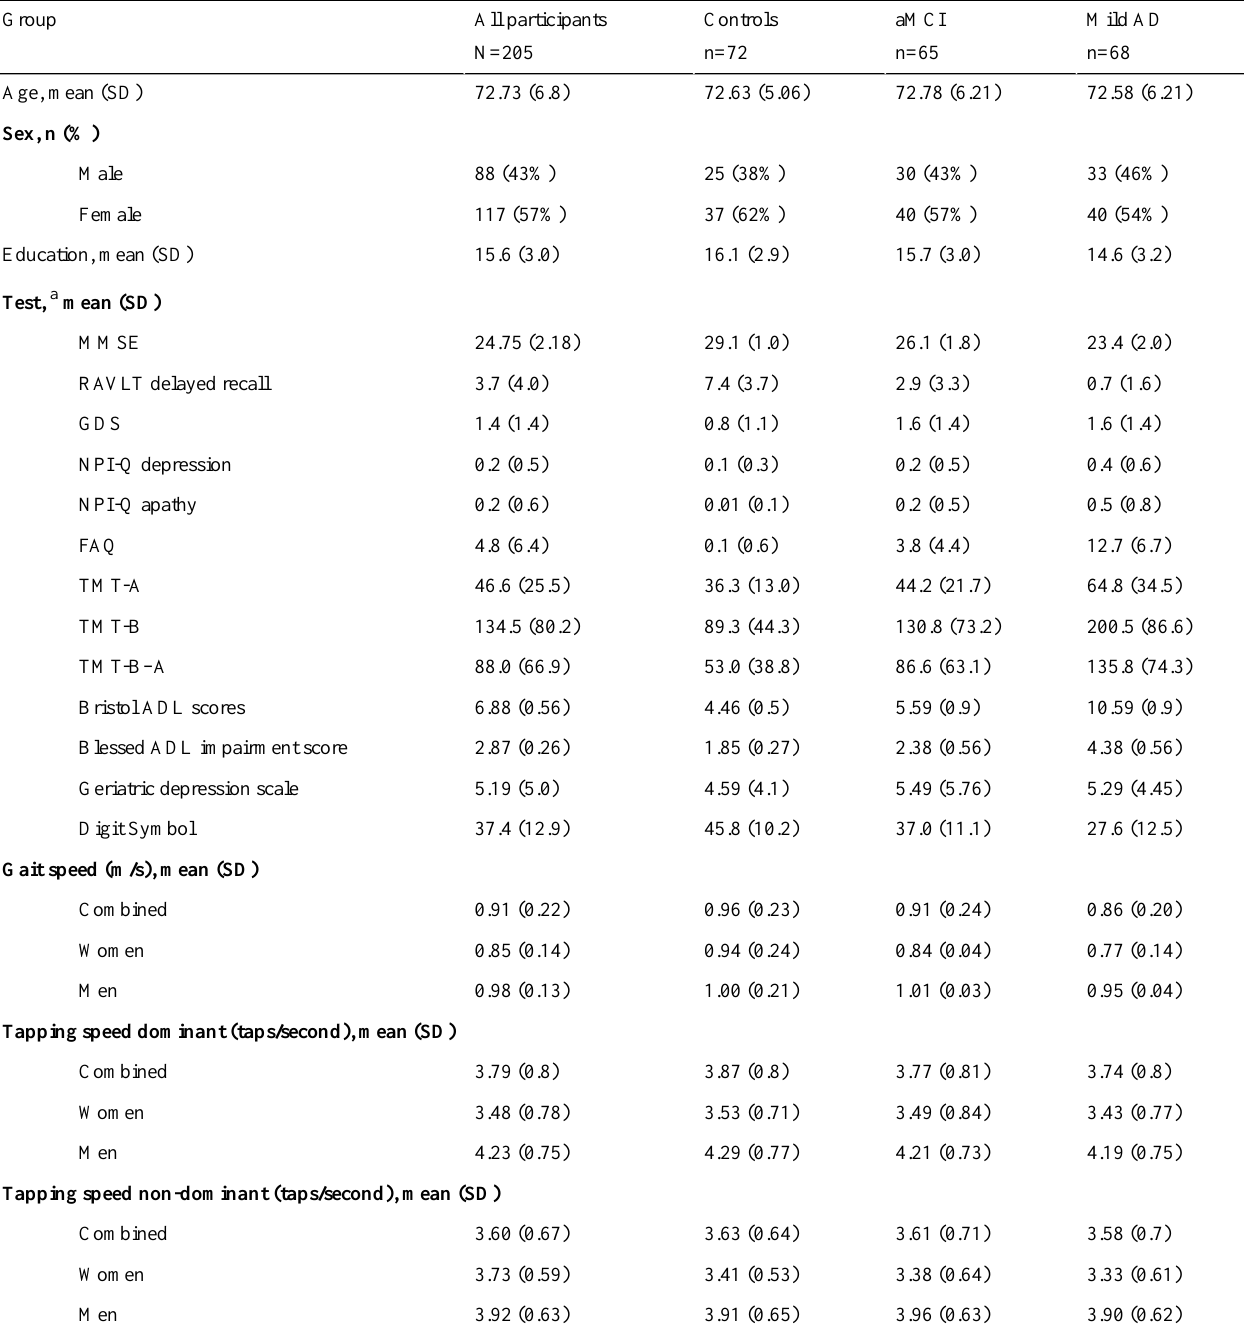
Table 1. Participant demographics and scores on cognitive tests for all participants, healthy controls, patients with amnestic-type mild cognitive impairment (aMCI), and patients with mild Alzheimer-type dementia